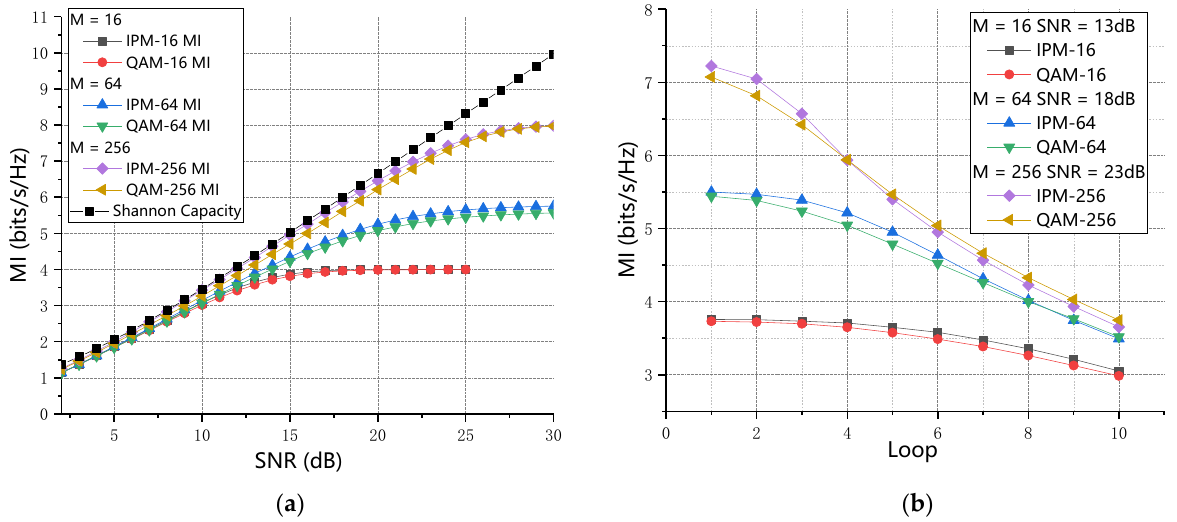
Figure 4. ( a ) MI versus SNR of different modulation format; ( b ) MI versus Loop.